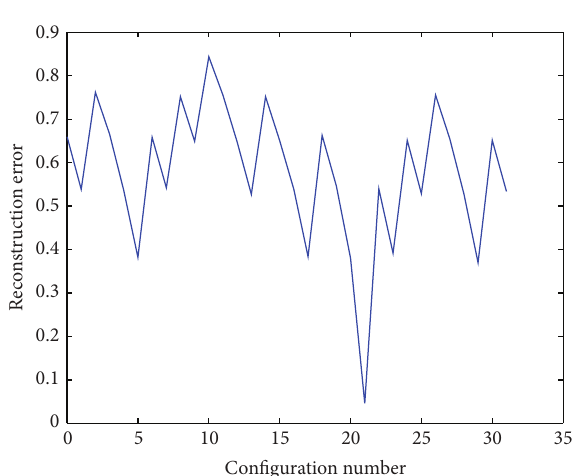
Figure 3: Reconstructed signal corresponding to the configuration with the smallest reconstruction error.